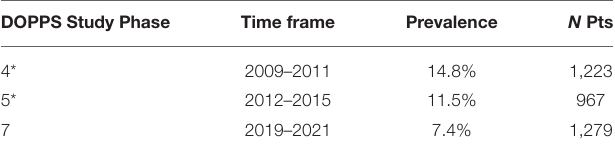
TABLE 2 | HCV prevalence among Chinese HD Patients in DOPPS, at baseline by study